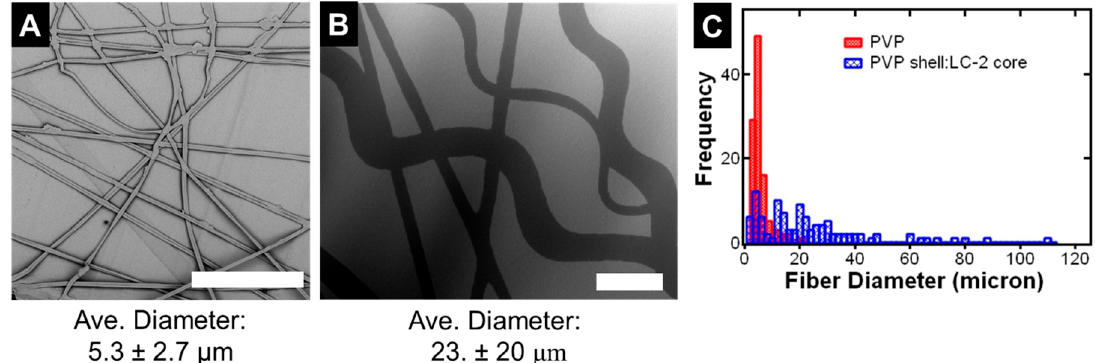
Figure 6. SEM micrographs of coaxially spun 15 wt. % PVP in ethanol shell (0.8 mL / hr) with ( A ) a 7:3 v:v toluene:acetone core (0.2 mL / hr) compared to ( B ) a 10:1 LC-2:solvent core both with a 100 µ m scale bar. Increase of the fiber diameter suggests successful incorporation of the LC. ( C ) Fiber size distributions comparing sample (A) and (B).